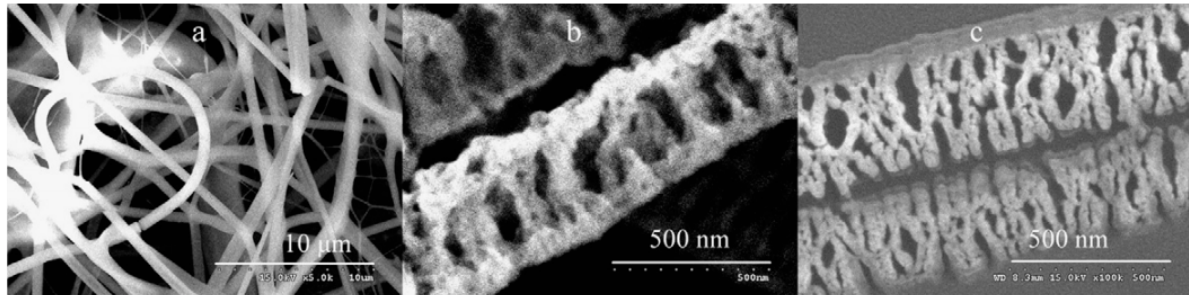
Figure 13. SEM images of polymer fiber after different post-treatment: ( a ) without post-treatment; ( b ) oxygen plasma etching; and ( c ) oxygen plasma etching and 500 °C annealing for 4 h. Reprinted with permission from [203]. Copyright 2010 Elsevier.